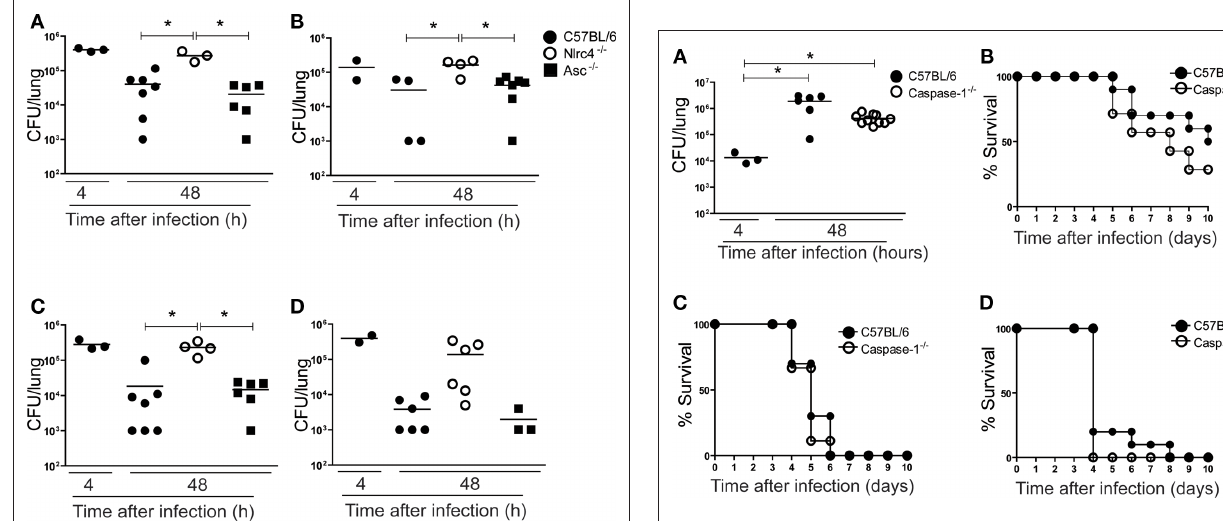
Figure 3 | Caspase-1 does not influence pulmonary infection by L. longbeachae . C57BL/6 (closed circles) and caspase-1 − / − (opened circles) mice were infected intranasally with Legionella longbeachae for determination of CFU in the lungs (A) and mice survival (B–D) . (A) Mice were sacrificed after 4 or 48 h after infection and dilutions of the lung homogenates were added to CYE agar plates for CFU determination. Each dot represents a single animal and the horizontal lines represent the average. Six to 10 mice were used per group. (B–D) Survival of mice inoculated with 10 5 (B) ; 10 6 (C) ; or 10 7 (D) L. longbeachae per mice over a period of 10 days. Ten mice were used per group. Data are representative of those found in four independent experiments. An asterisk indicates a P value of <